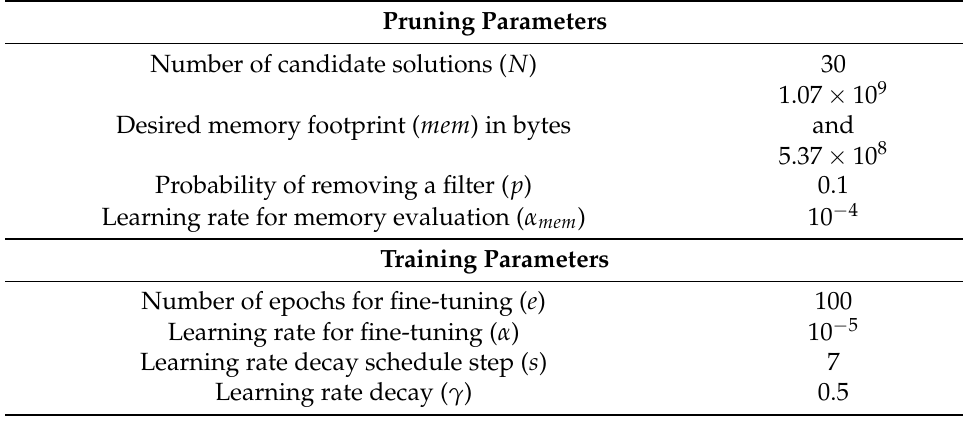
Table 2. Parameters used to evaluate the proposed